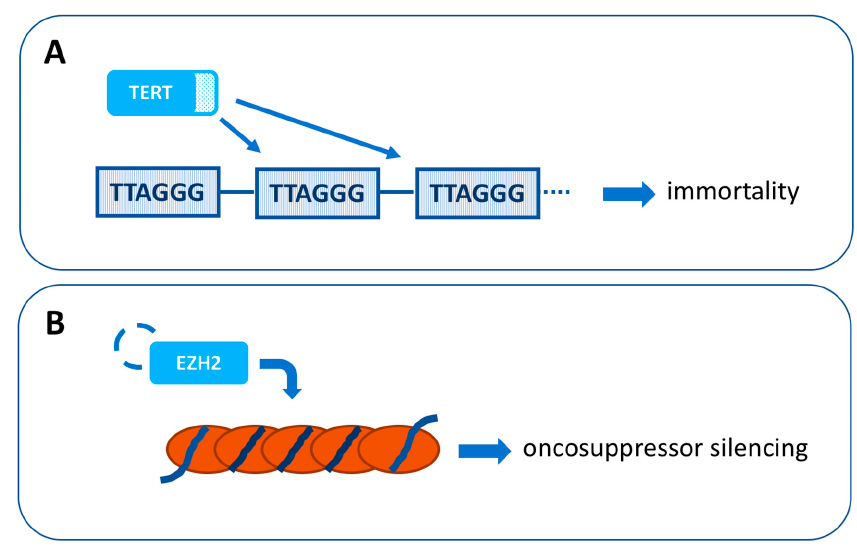
Figure 4. New potential therapeutic targets for conjunctival melanoma. ( A ) Telomerase reverse transcriptase (TERT) is a catalytic subunit of the telomerase enzyme that catalyzes the addition of repetitive sequences in the terminal TTAGGG of chromosomes. TERT promoter mutations, which cause an increased TERT expression, are detectable in 32–41% of conjunctival melanomas. ( B ) Enhancer of zeste homolog 2 (EZH2) is a histone methyltransferase which catalyses trimethylation of lysine 27 in histone H3 (H3K27me3), leading to transcriptional silencing of oncosuppressors. EZH2 is highly expressed in 50% of primary conjunctival melanomas and 88% of lymph node